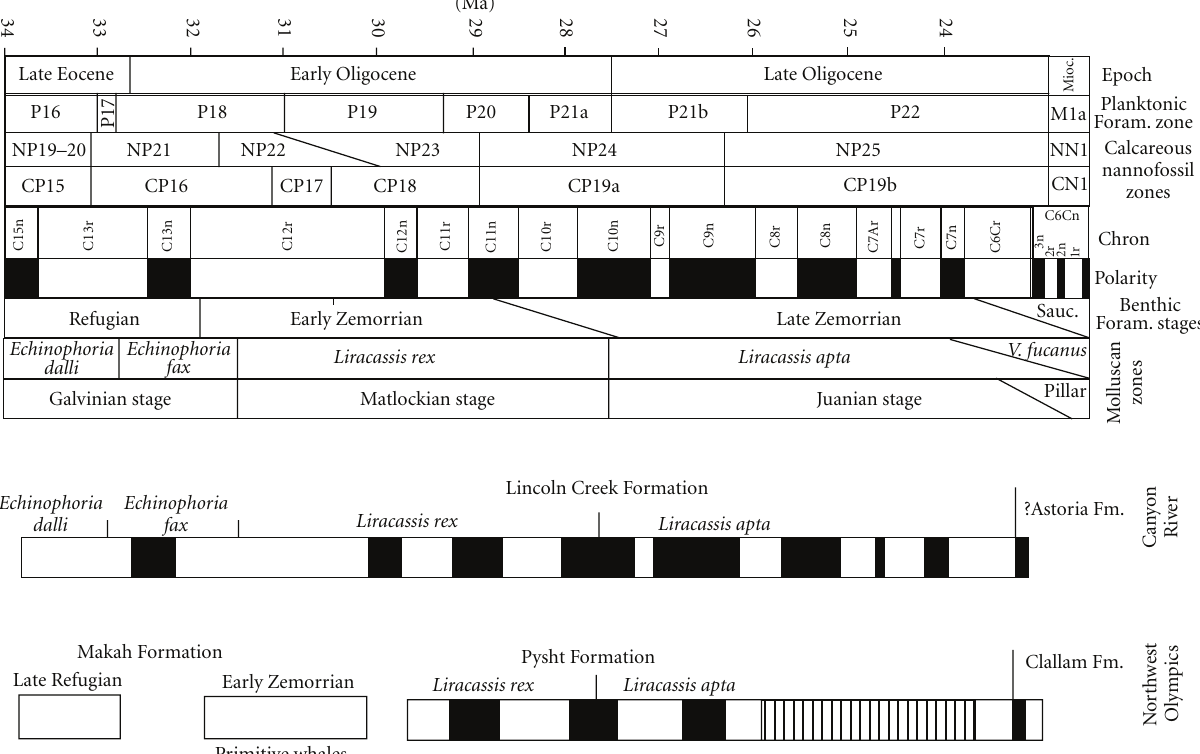
Figure 10: Correlation of the three Makah sections, based on the dates and age constraints discussed in the text. Lincoln Creek Formation magnetostratigraphy after Prothero and Armentrout [17]. Time scale after [15, 56].